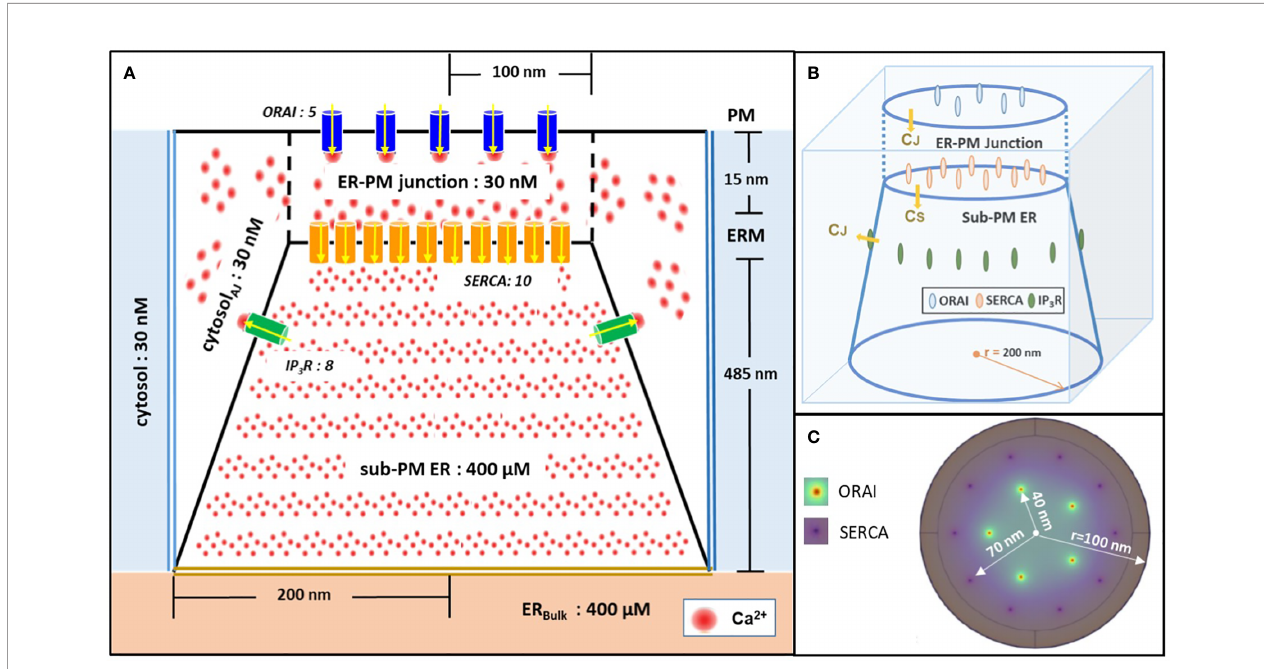
FIGURE 1 | Schematic representation of the model geometry of the ER-PM junction and sub-PM ER used to investigate the origin of the Ca 2+ microdomains in T cells. (A) Frontal diagram showing the dimensions of the cone that represents the sub-PM ER, of the junction and of the portion of the cytosol considered in the simulations. ORAI1 channels are in blue, SERCA pumps in yellow and IP 3 Rs in green. Plain lines represent membrane boundaries; dashed lines, fi ctitious limits between the junction and the cytosol and double lines indicate the limits of the simulated system. The resting Ca 2+ concentrations considered as initial conditions and boundary conditions in the two compartments are indicated. (B) 3D view of the model geometry (C) Upper view of the positions of the ORAI1 channels on the PM, in green, and of the ERM, in purple, using COMSOL. Not to scale. This geometry is based on McIvor et al. (32). See text for